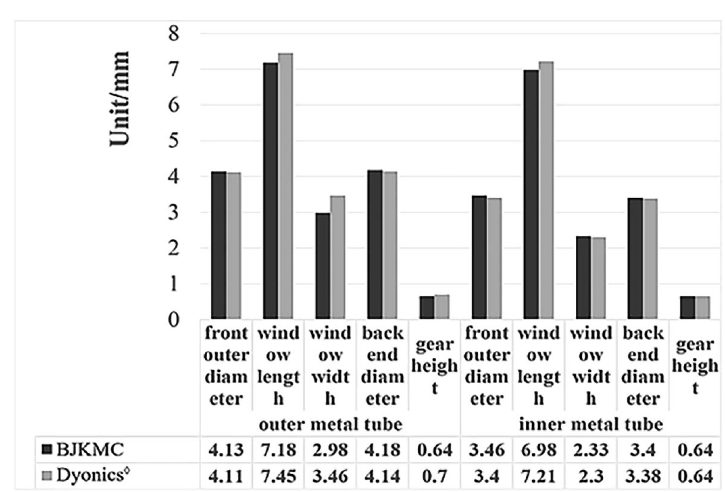
Figure 9. Key dimensions of two kinds of shavers.